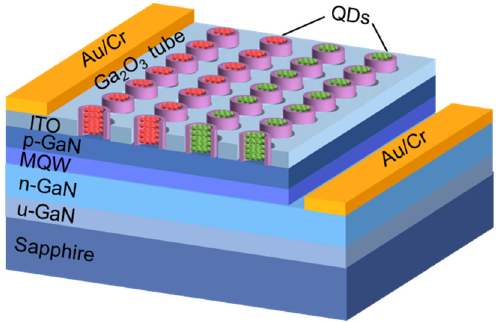
Figure 8. Schematic of the white LED with β -Ga 2 O 3 micro-/nanotubes.